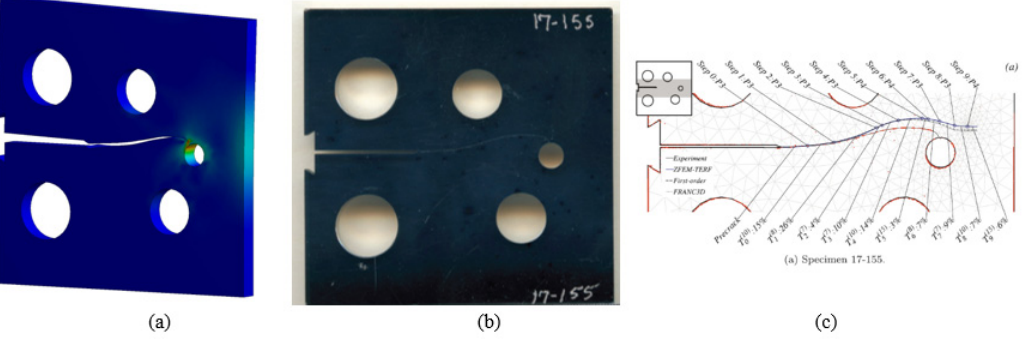
Figure 6. Specimen 3, crack propagation path ( a ) ANSYS results, ( b ) experimental results [46], and ( c ) numerical results [47].